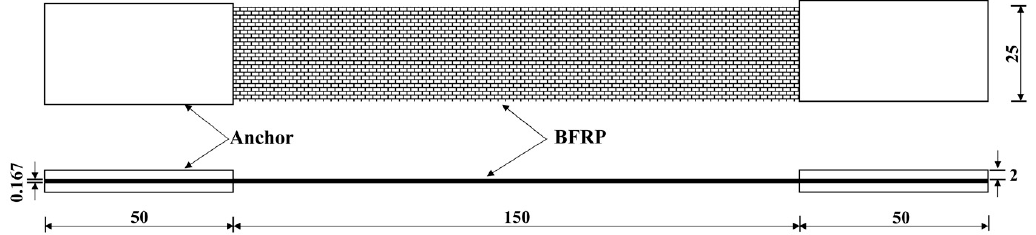
Figure 2. Basalt fiber-reinforced polymer (BFRP) specimens for tensile test.